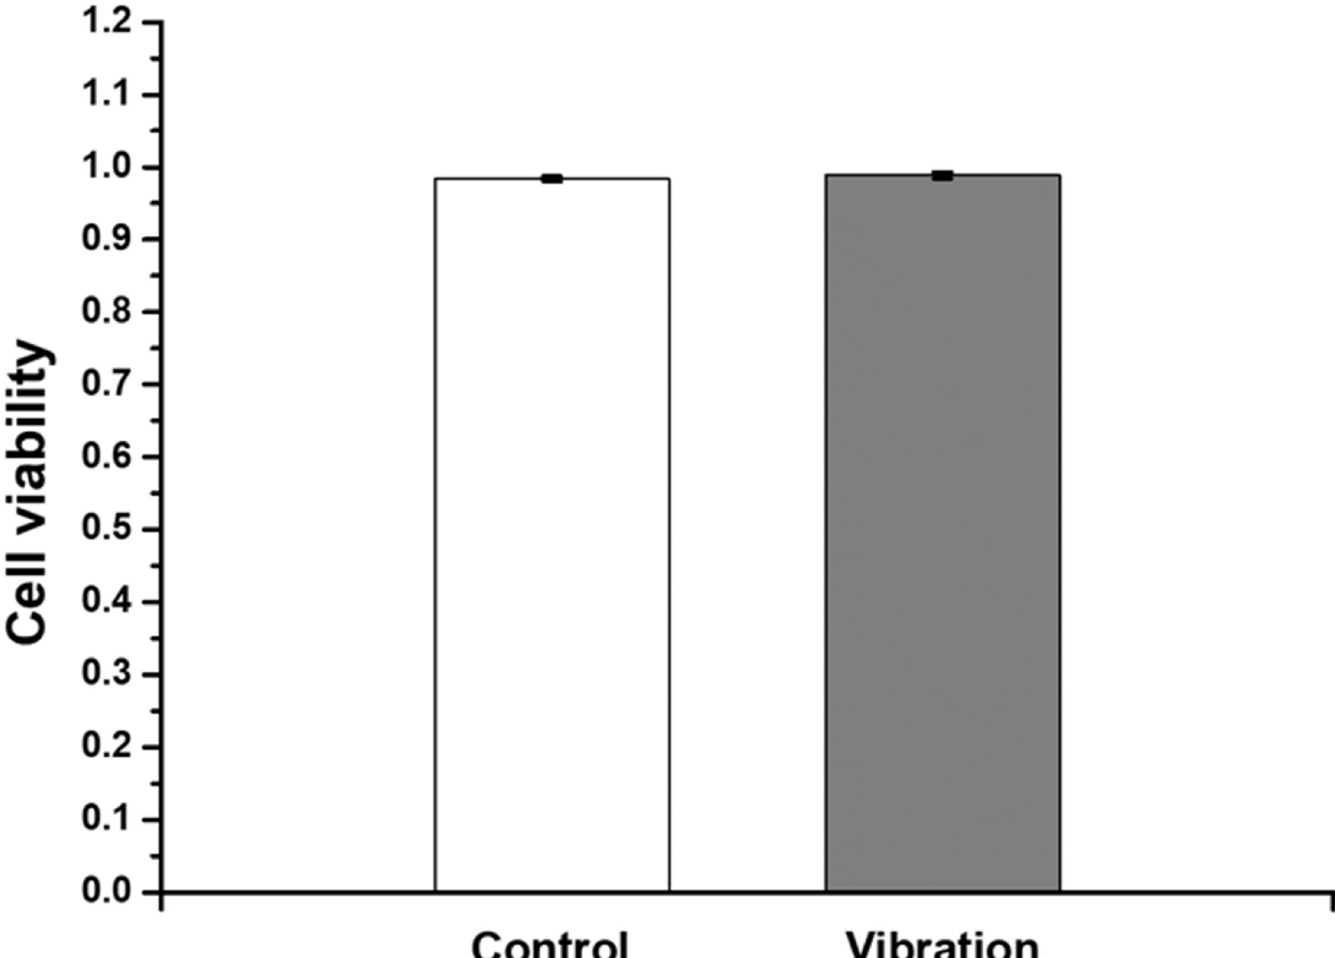
Fig 3. Cell viability of HaCaT cells following exposure to mechanical vibration. The viable and nonviable cells were counted, and the viability was calculated by dividing the number of viable cells by that of total cells ( n =